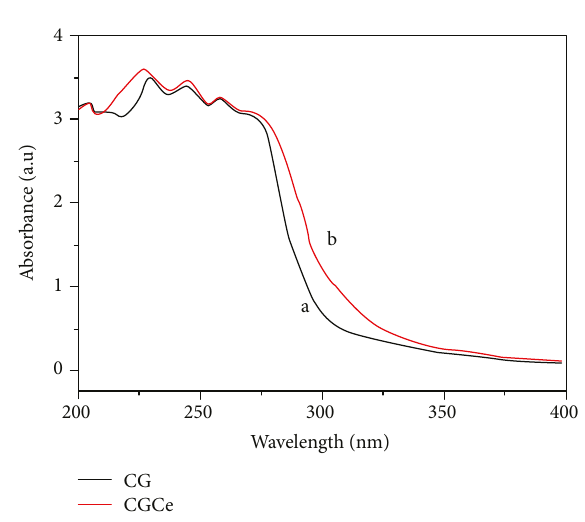
Figure 2: UV-vis spectra of CG and